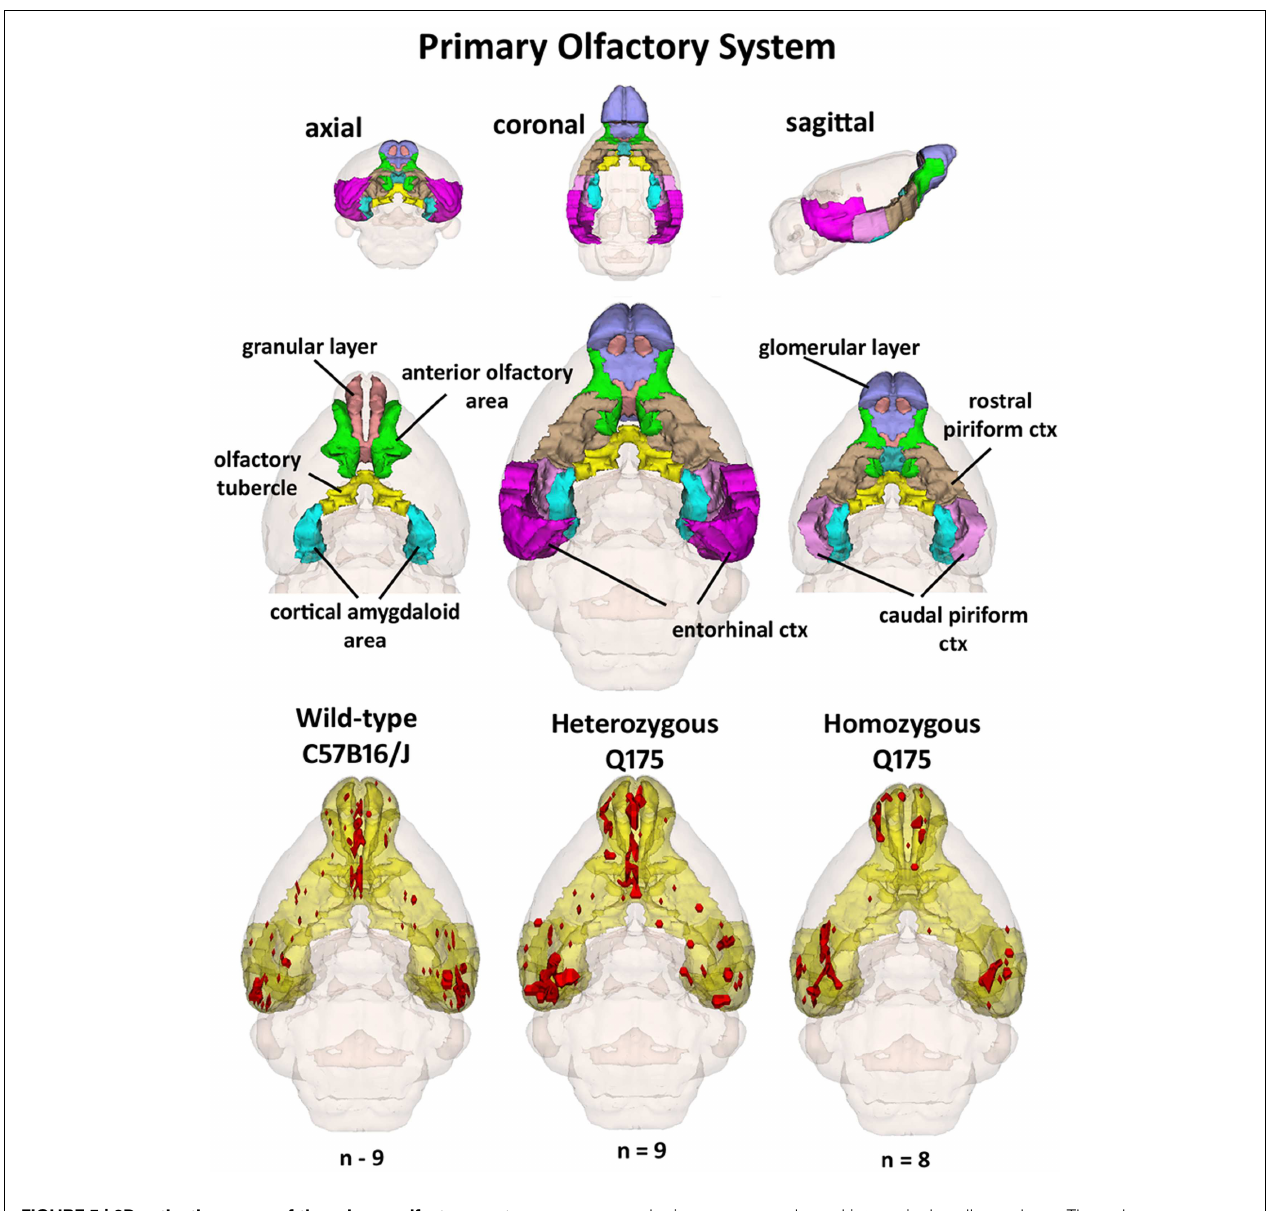
FIGURE 5 | 3D activation maps of the primary olfactory system . Shown is a 3D color representation of the different brain areas comprising the primary olfactory system.The layout is similar to that described in Figure 4 . In the three illustrations below, these